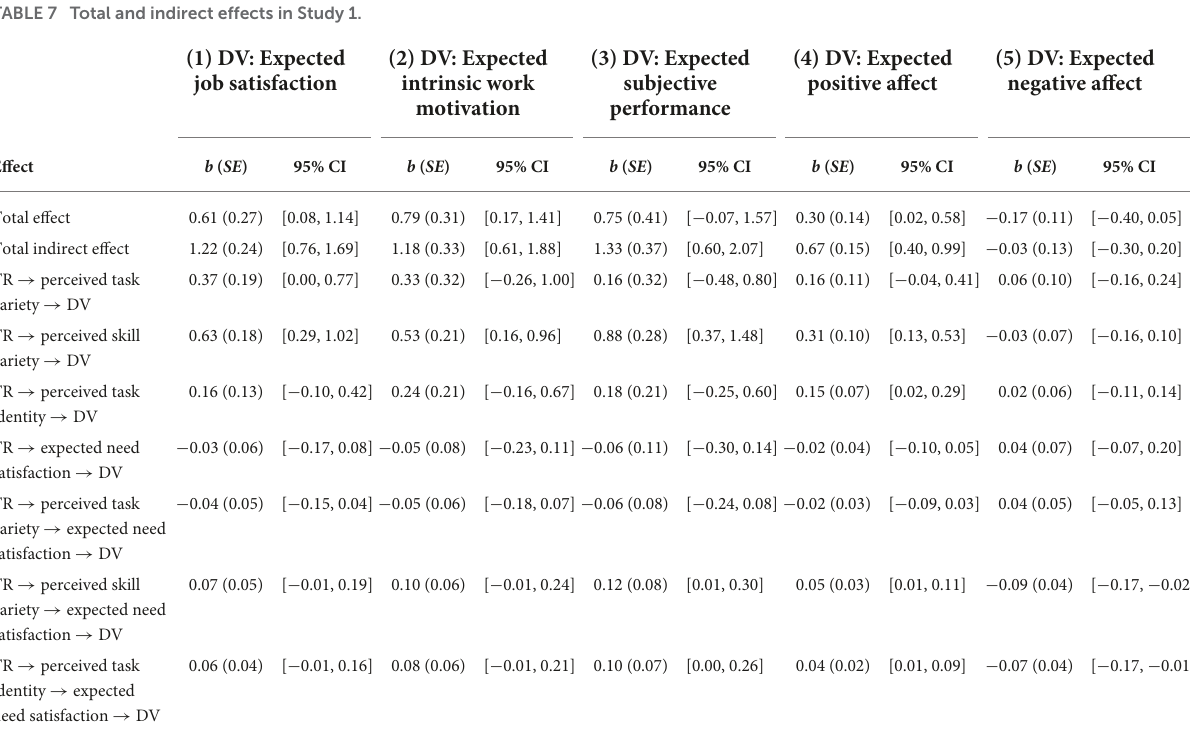
TABLE 7 Total and indirect effects in Study